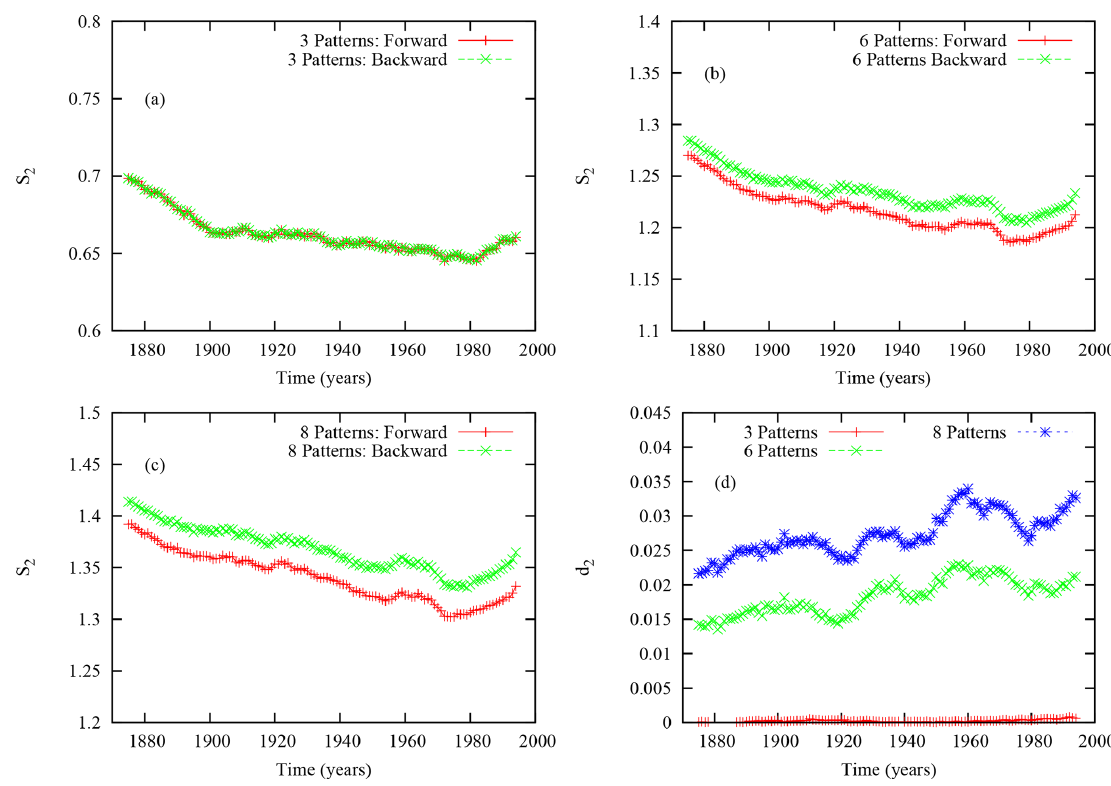
, for (a) three patterns, (b) six patterns, and (c) eight patterns. 2